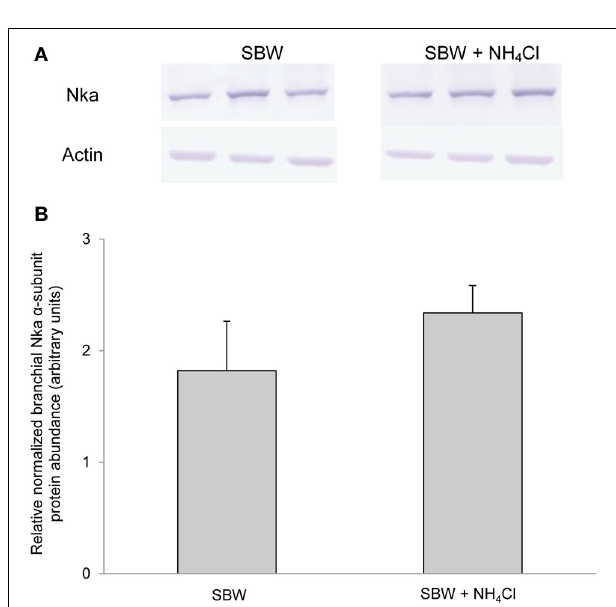
FIGURE 10 | Effects of exposure to ammonia in slightly brackish water on Na + /K + -ATPase (Nka) protein abundance. Protein abundance of Nka based on the α 5 anti-NKA antibody, which is known to react with all Nka/NKA α -isoforms, in gills of Periophthalmodon schlosseri kept in slightly brackish water (SBW; salinity 3) for 2 weeks (control) or after 6 days of transfer from SBW to SBW containing 75mmol l − 1 NH 4 Cl. (A) The immunoblots of Nka and actin. (B) The intensity of the Nka band was normalized with respect to that of actin. Results represent mean + s.e.m. ( N = 3).